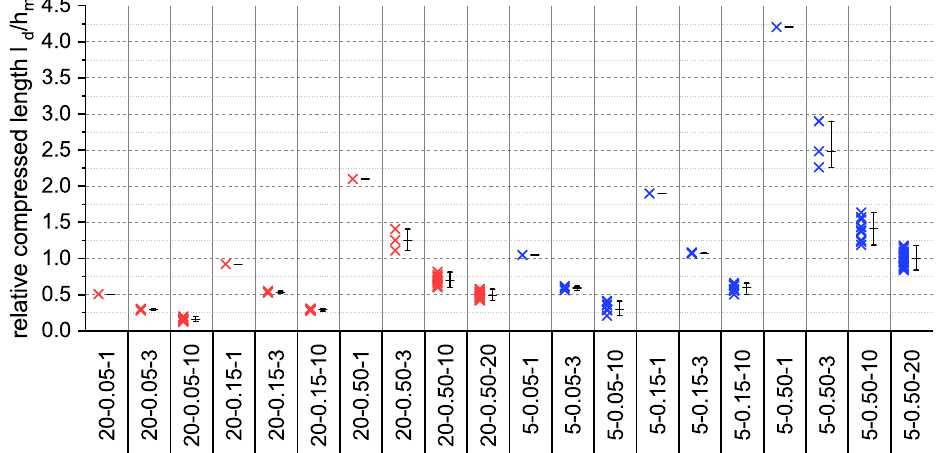
Figure 5. Calculated relative compressed lengths for first series of